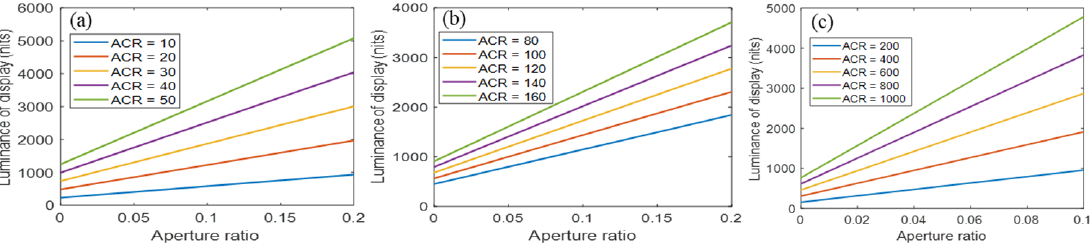
Figure 3. The required luminance of display, as a function of aperture ratio, for achieving the listed ACR under three ambient light illuminances: ( a ) 2000 lux, ( b ) 450 lux, and ( c ) 200 lux. Meanwhile, the power consumption of the display is also a ff ected by the e ffi ciency of LED